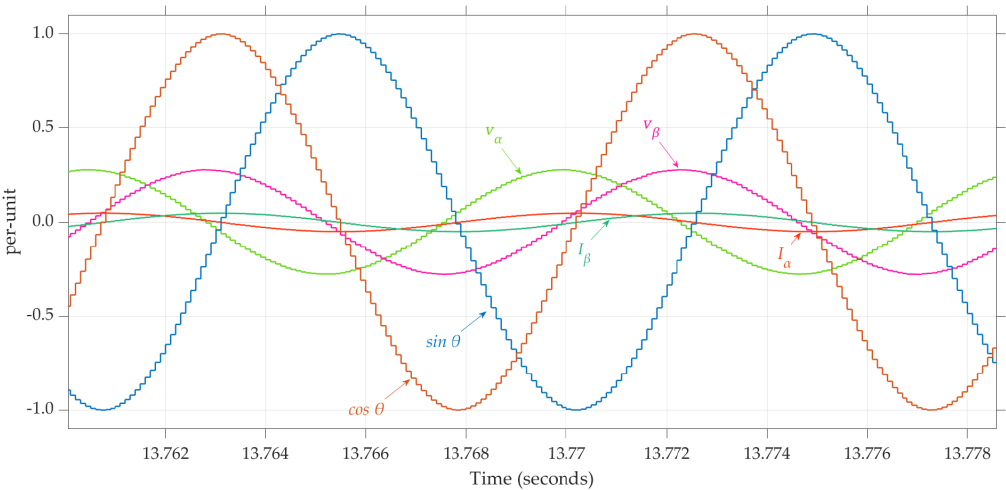
Figure 7. Example of recorded data.